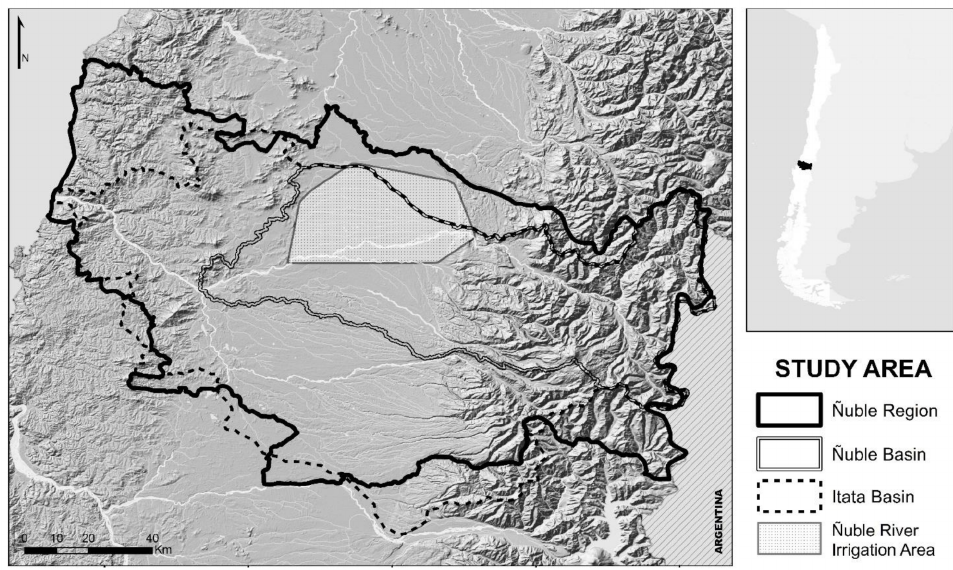
Figure 1. Study area. Ñuble River irrigation system (ÑRIS) (white area), Ñuble River basin (double black solid line), Itata River basin (dotted line) and Ñuble Region (black solid